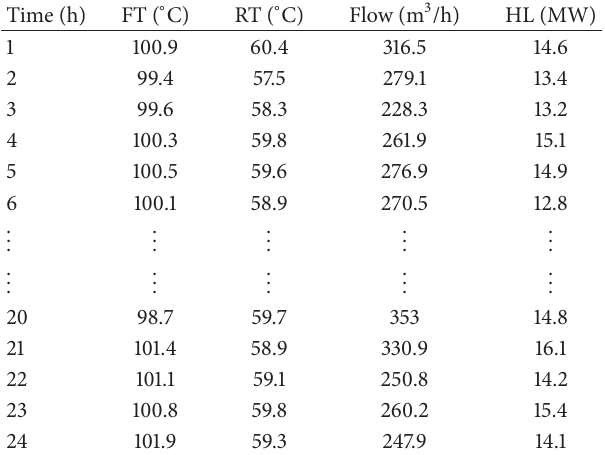
Table 2: Typical data samples for one day from the Eidsiva